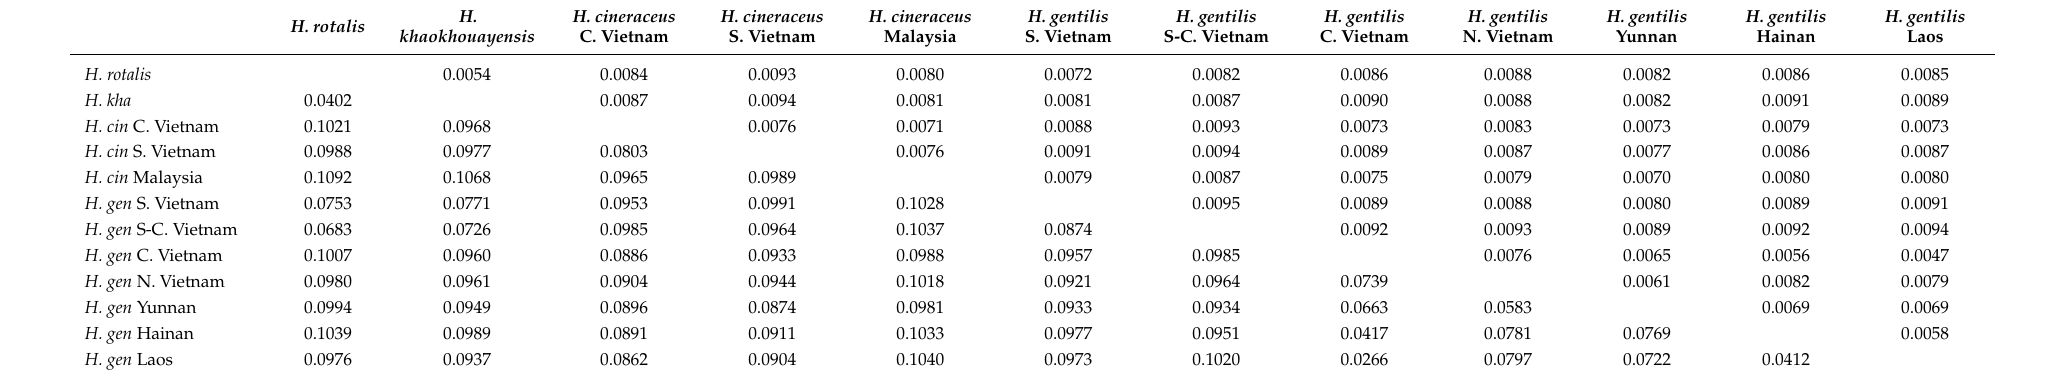
Table 3. Between-group pairwise p-distances for H. gentilis and related forms. Distances are shown below the diagonal, and standard error estimates are shown above the diagonal. Groups correspond to the cytb tree branches on Figure